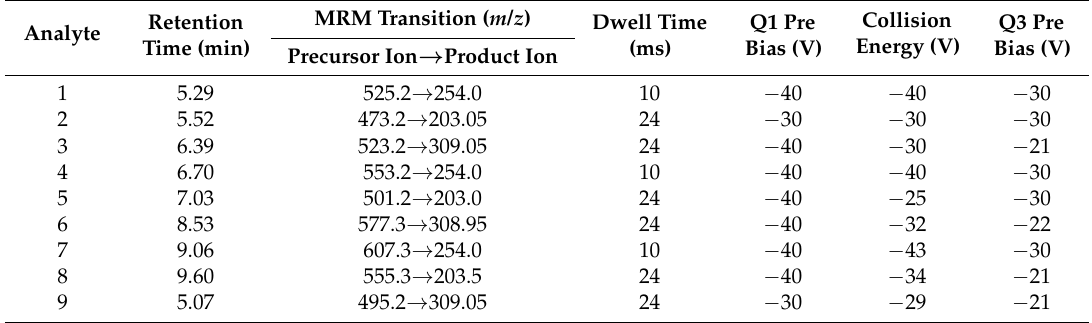
Table 7. Optimized MRM parameters of the nine standards in Angelicae Dahuricae Radix.